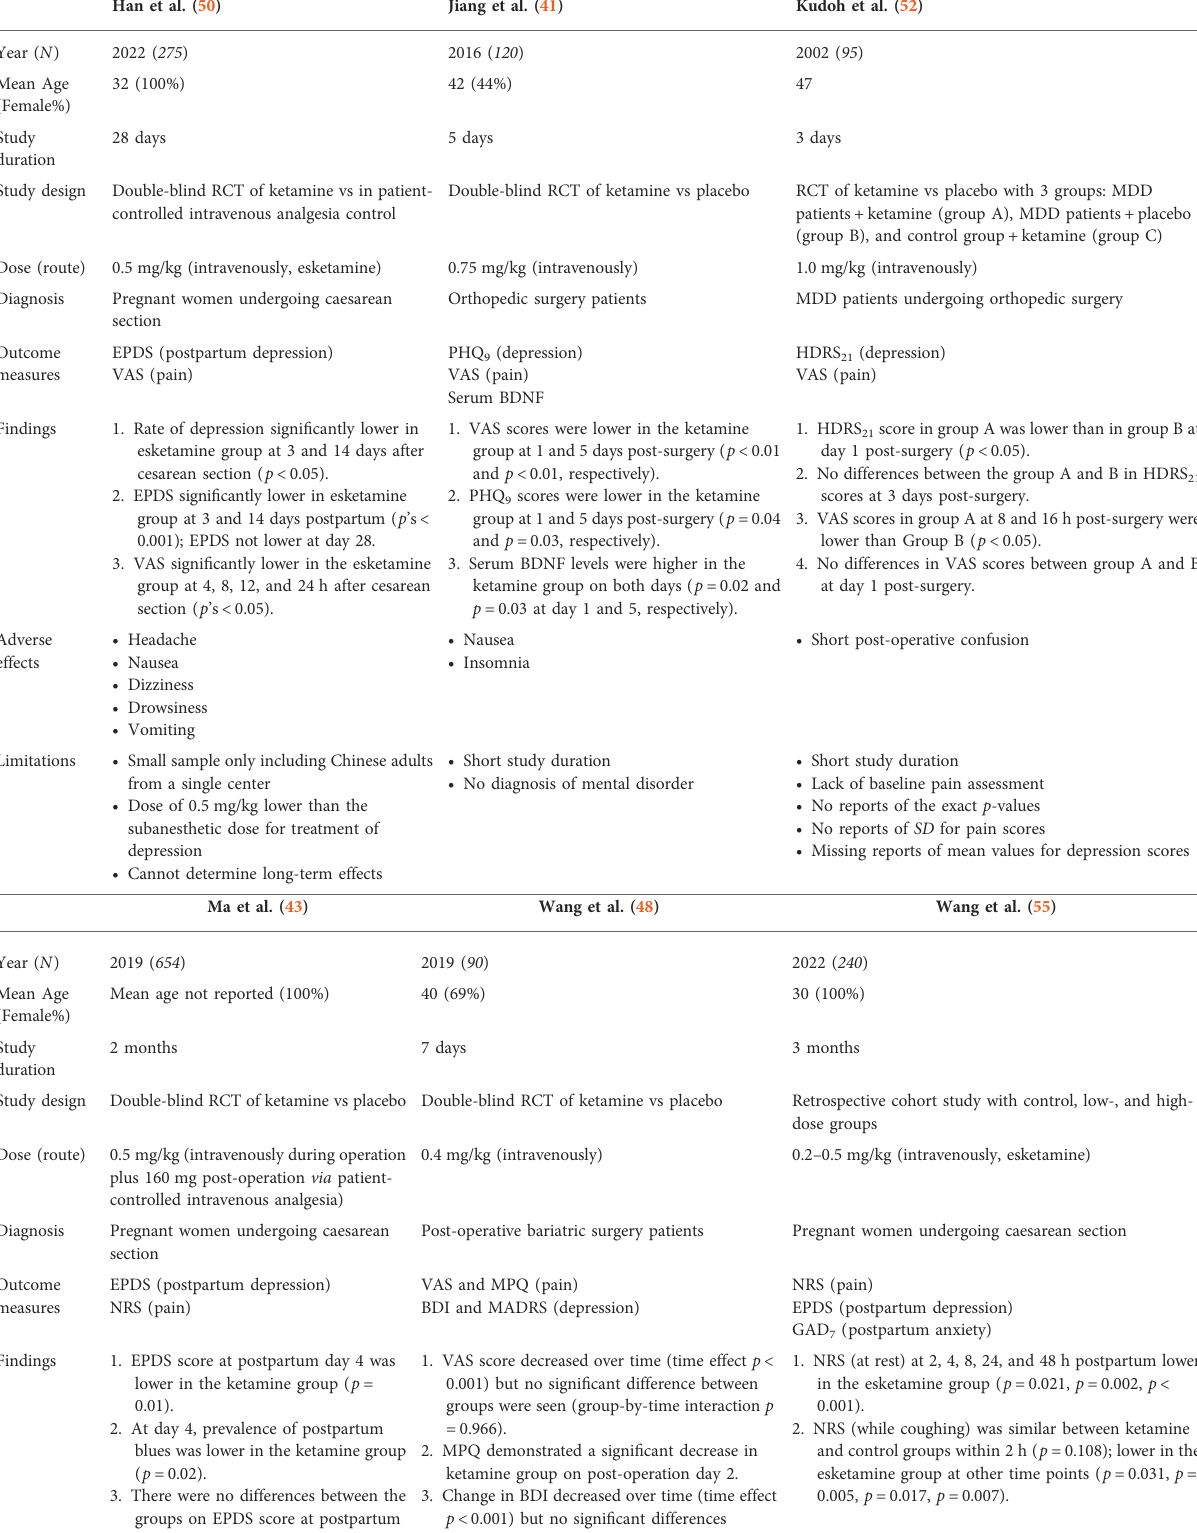
TABLE 1B Selected characteristics of clinical trials and observational studies pertaining to